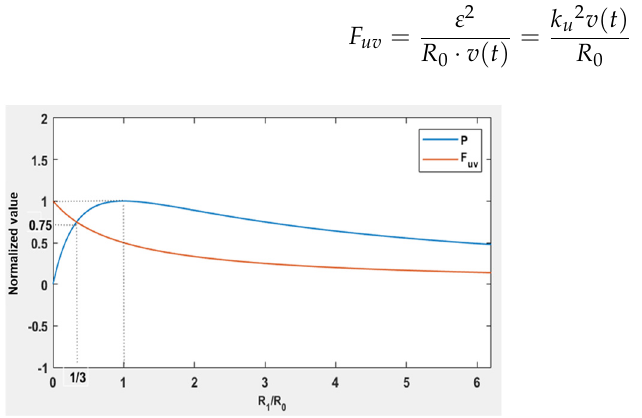
Figure 3. Change in normalized value with